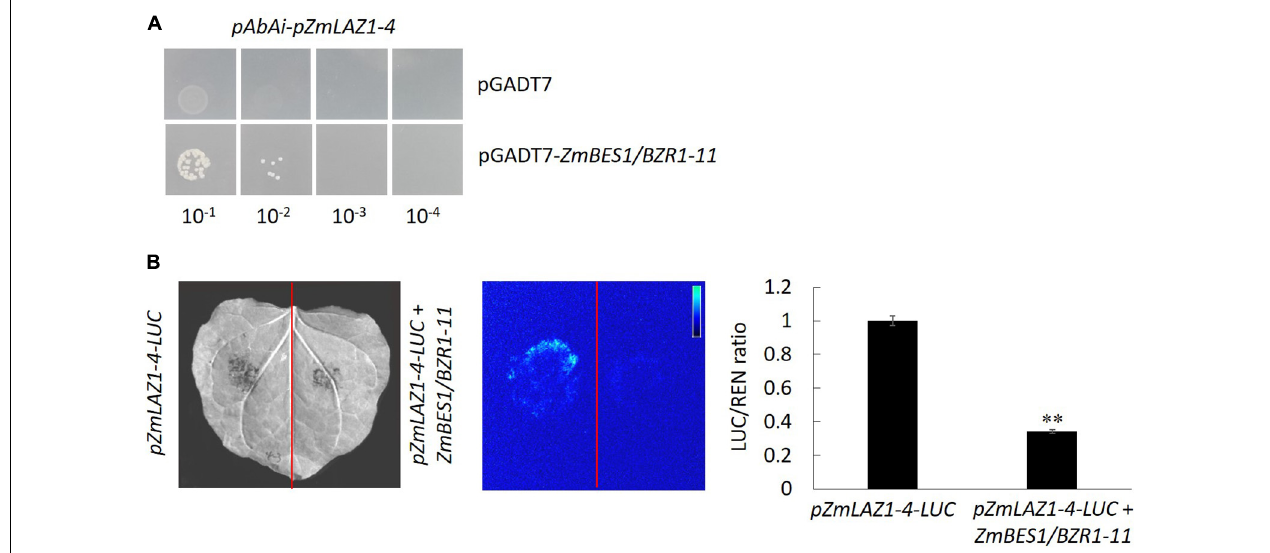
FIGURE 7 | Confirmation of ZmBES1/BZR1-11 binding to ZmLAZ1-4 promoter. The Y1H (A) and dual-luciferase assay (B) were performed to verify the binding and negative regulation of ZmLAZ1-4 by ZmBES1/BZR1-11 transcription factor. The tobacco leaves were co-infiltrated by 35S - ZmBES1/BZR1-11 and pZmLAZ1-4-LUC , incubated at 22 ◦ C and 14 light/10 dark for 3 days, visualized for LUC signal, and used to measure activity LUC and REN. ∗∗ p < 0.01.